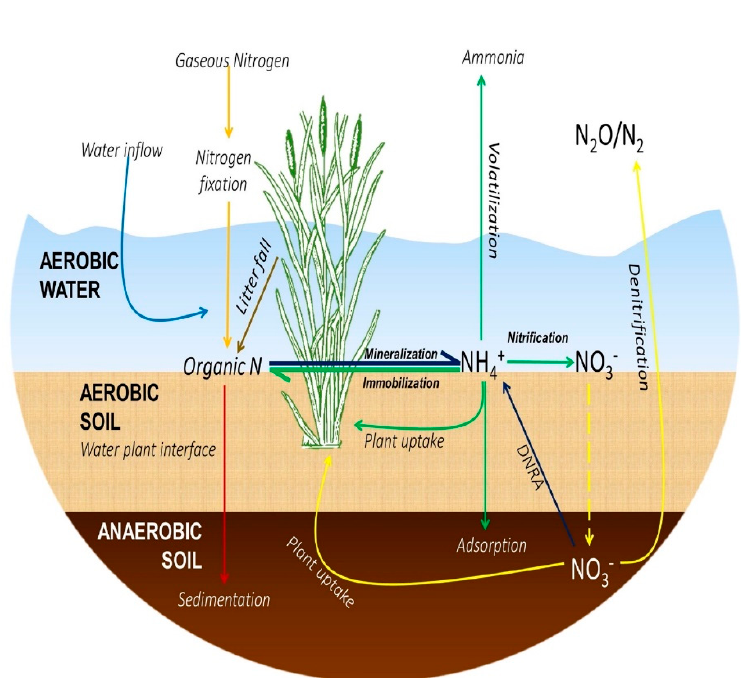
Figure 1. Illustration of the potential pathway for nitrogen transformation in wetlands.